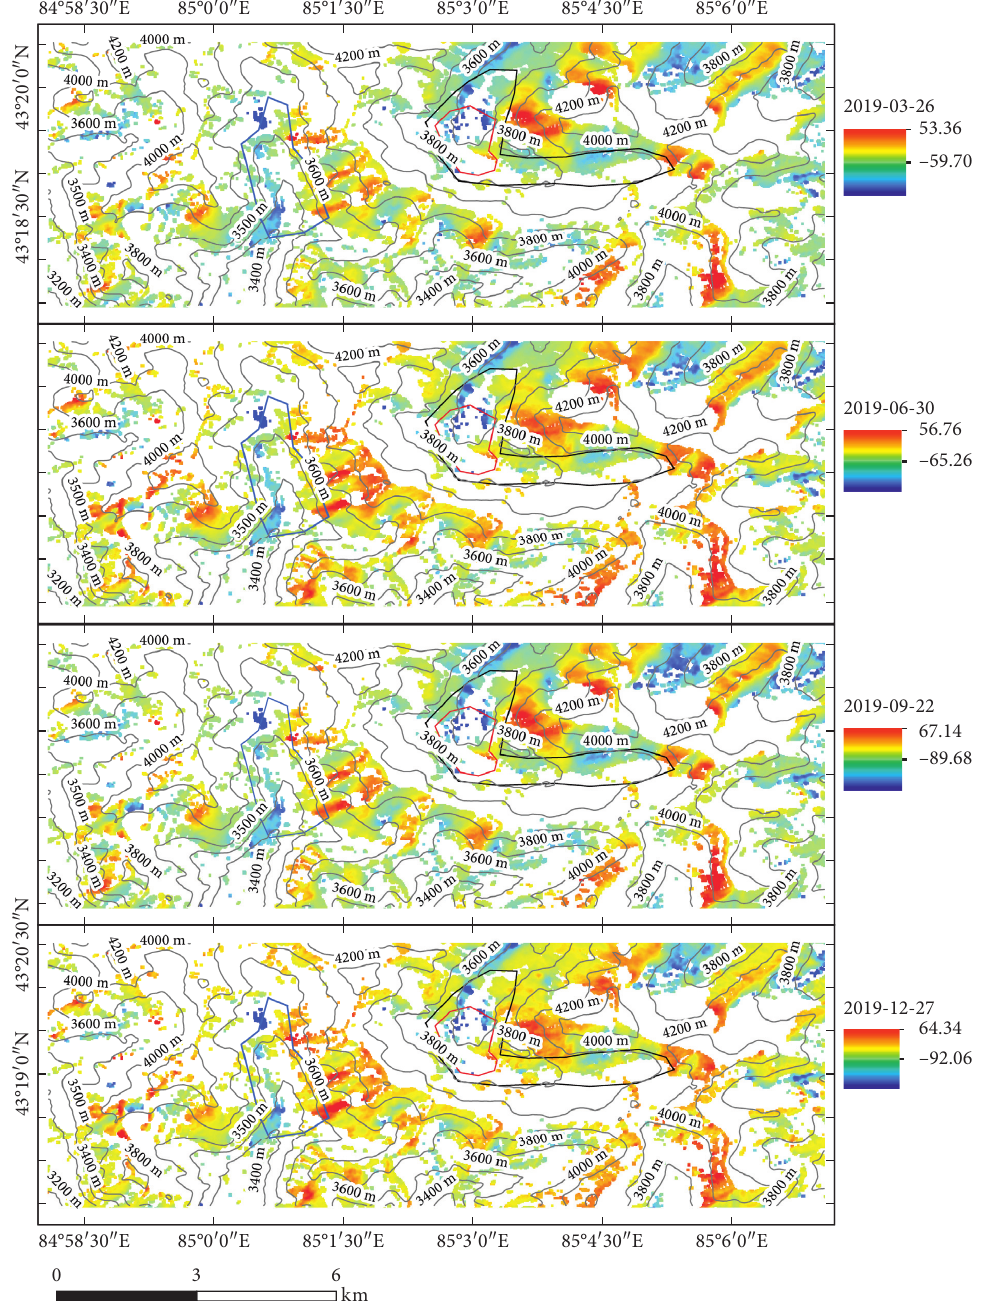
Figure 9: LOS deformation of 2019, in